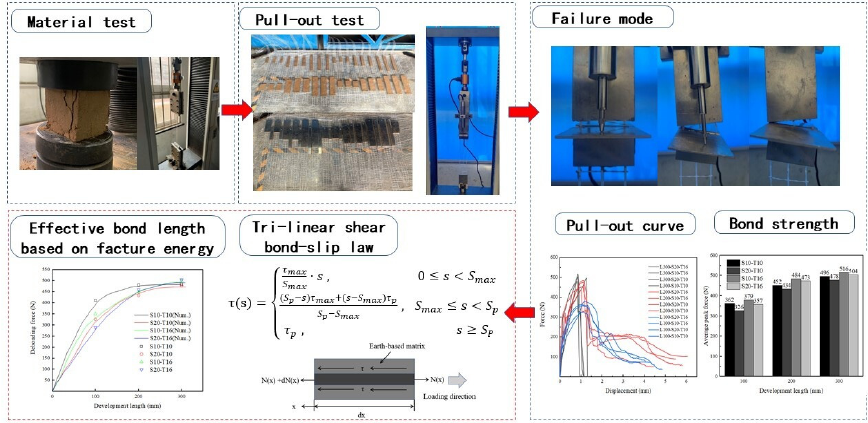
Figure 1. Figure 1. Flowchart.